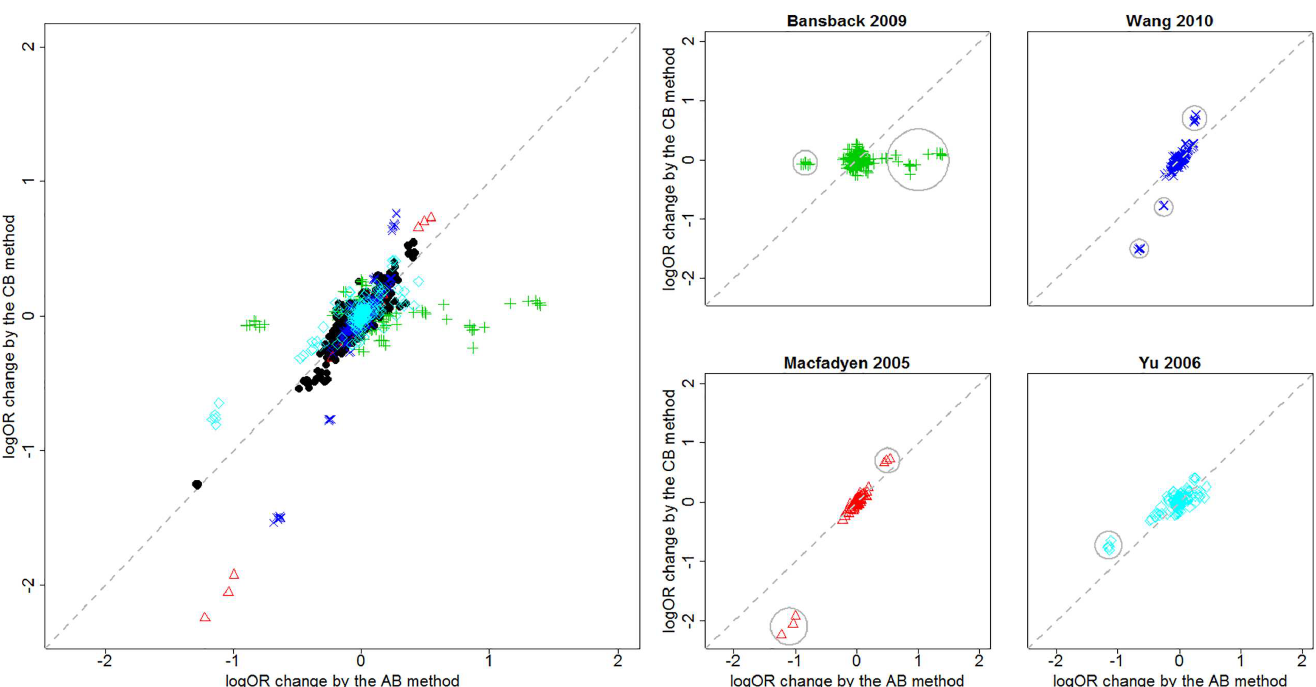
Fig 2. Scatterplots of logOR changes after and before excluding trials for the 20 networks. The x-axis labelschangesobtainedfrom the AB ð i Þ approach,i.e., log OR , whilethe y-axis labels changesobtainedfrom the CB approach, i.e., log OR AB OR AB scatters deviatingfrom the identity line in color. Right panel excerpts colored scatters.